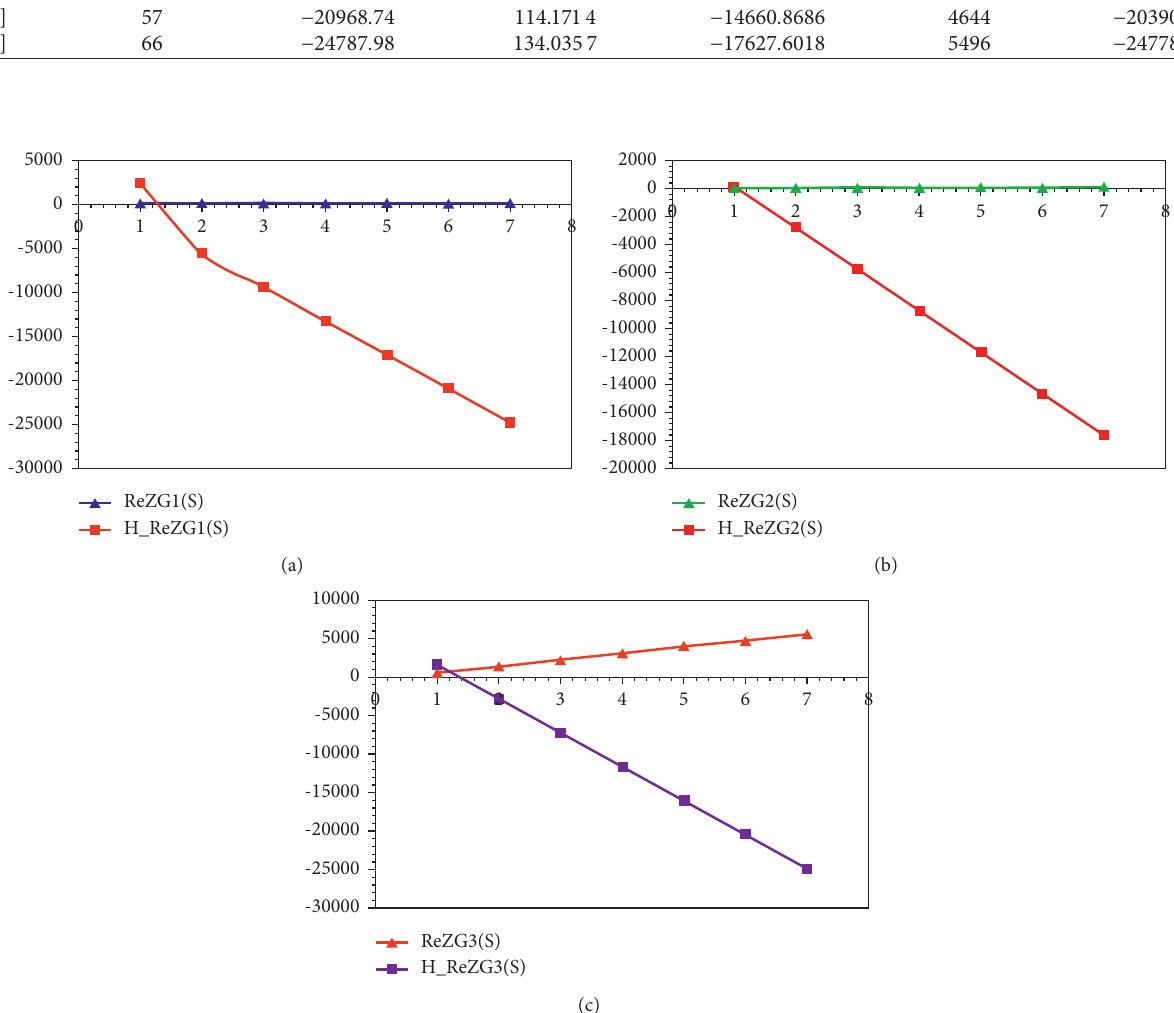
Figure 9: (a) The redefined first Zagreb index, (b) the redefined second Zagreb entropy, and (c) the Redefined third Zagreb index, with respective heat of formation for GST − SL [ n ]